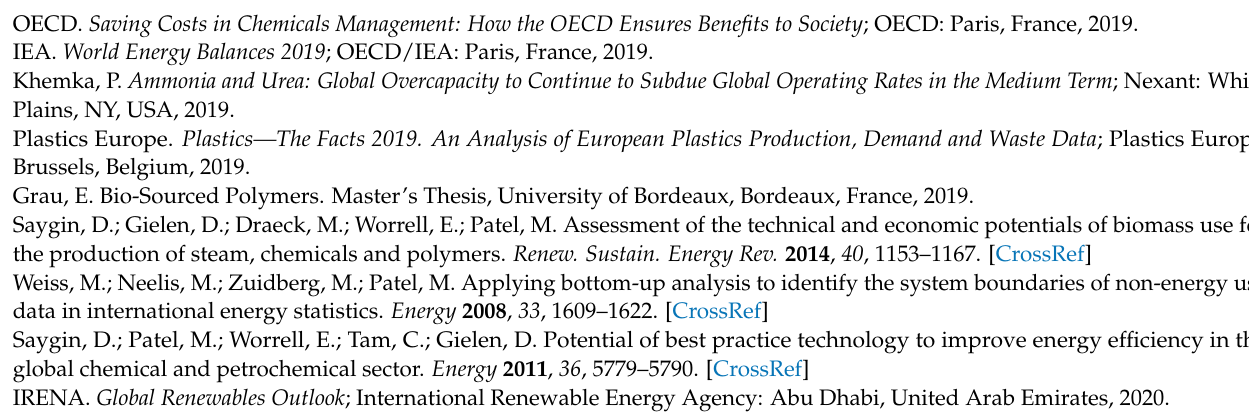
Table B-1. Estimated production volume, specific energy consumption and fuel mix of the major Table B-3: Technology penetration assumptions in the 1.5 ◦ C case in 2050; Table B-4: